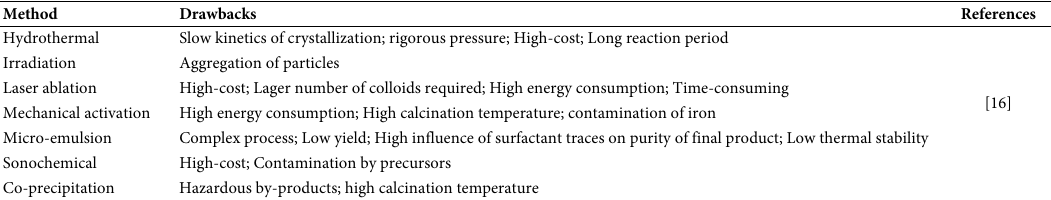
Table 1. Limitations of conventional nanoparticle synthesis